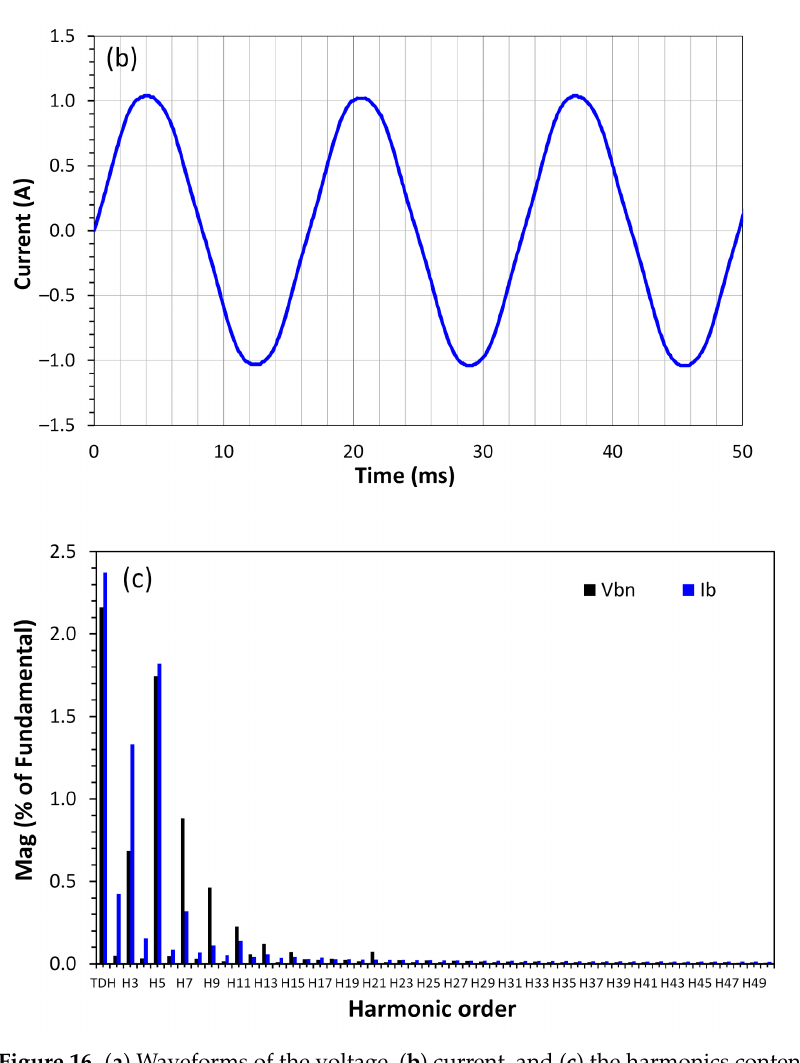
Figure 16. ( a ) Waveforms of the voltage, ( b ) current, and ( c ) the harmonics content for these signals.